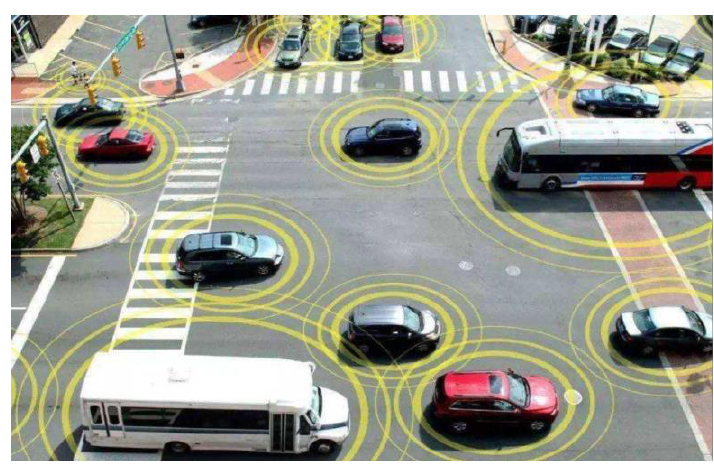
Figure 4. Architecture model of vehicle linkage network.